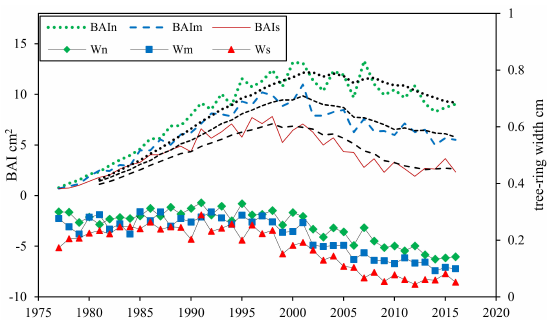
Figure 3. Annual variations in tree-ring width and basal area increment (BAI, cm 2 ) of normal, mild declining and severe declining P. simonii . W n represents the tree-ring width of normal poplar; W m represents the tree-ring width of mild declining poplar; W s represents the tree-ring width of severe declining poplar. BAI n , BAI m and BAI s represent the basalt area increment of normal, mild declining and severe declining P. simonii. separately. The dotted lines represent the smoothed results using a 10-year fast Fourier transform (FFT) filter to emphasize long-term